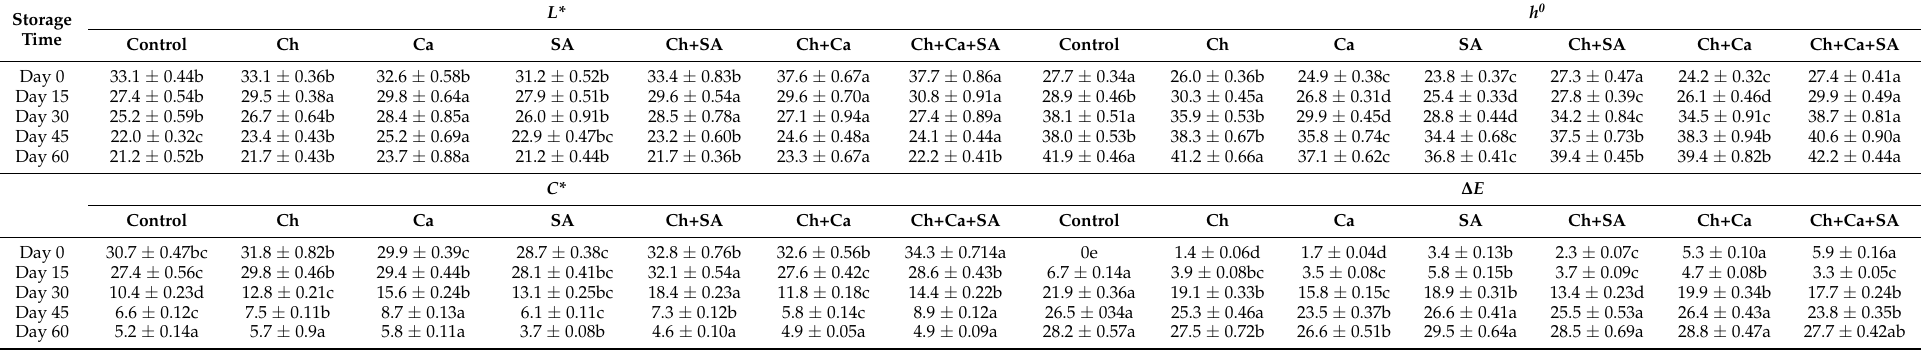
Table 3. Effect of different preharvest treatments on ‘Khesab’ fruit color attributes during cold